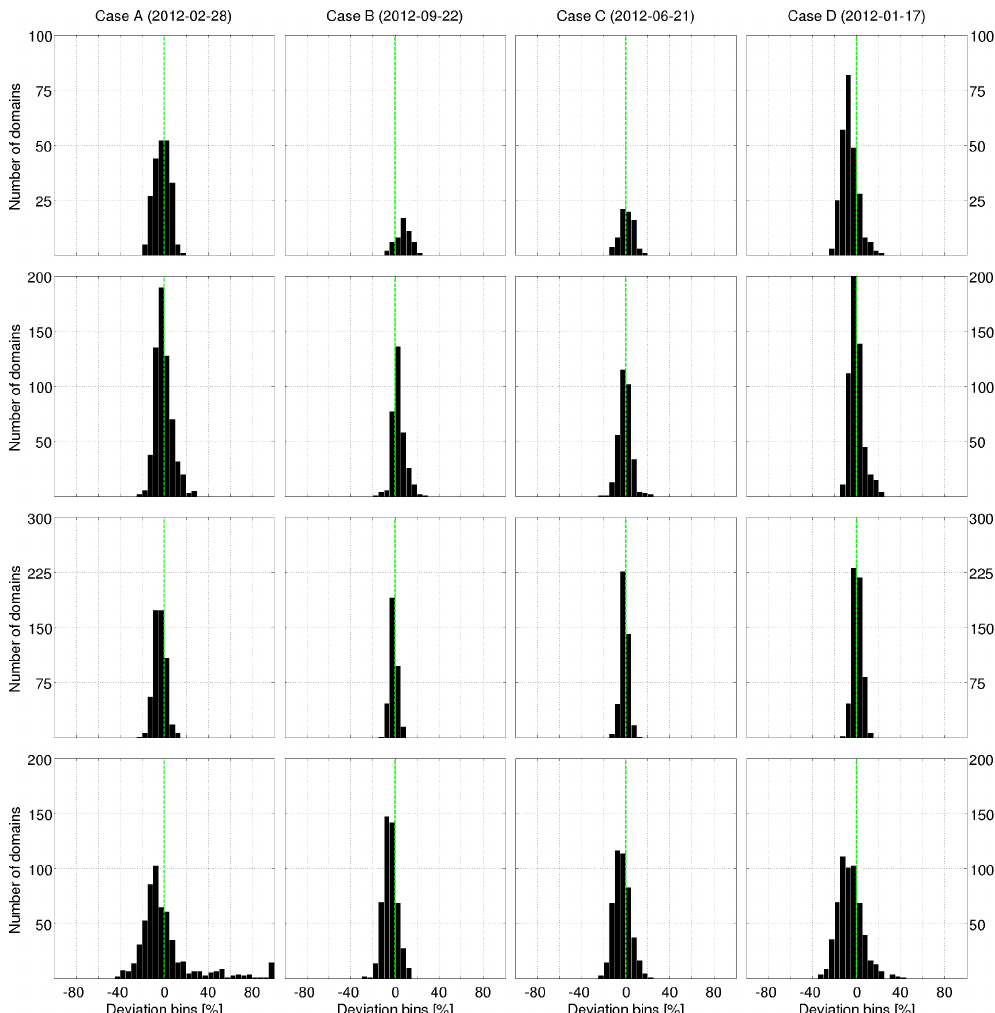
Figure 8. Pressure layer corresponding histograms of TM case study A (28 February 2012, first column), B (22 September 2012, second column), C (21 June 2012, third column) and D (17 January 2012, fourth column). The number of relative difference (TM − MLS) domains in a certain deviation bin of a width of 5 % between TM and Aura MLS solution is shown. From top to bottom, the pressure layers are